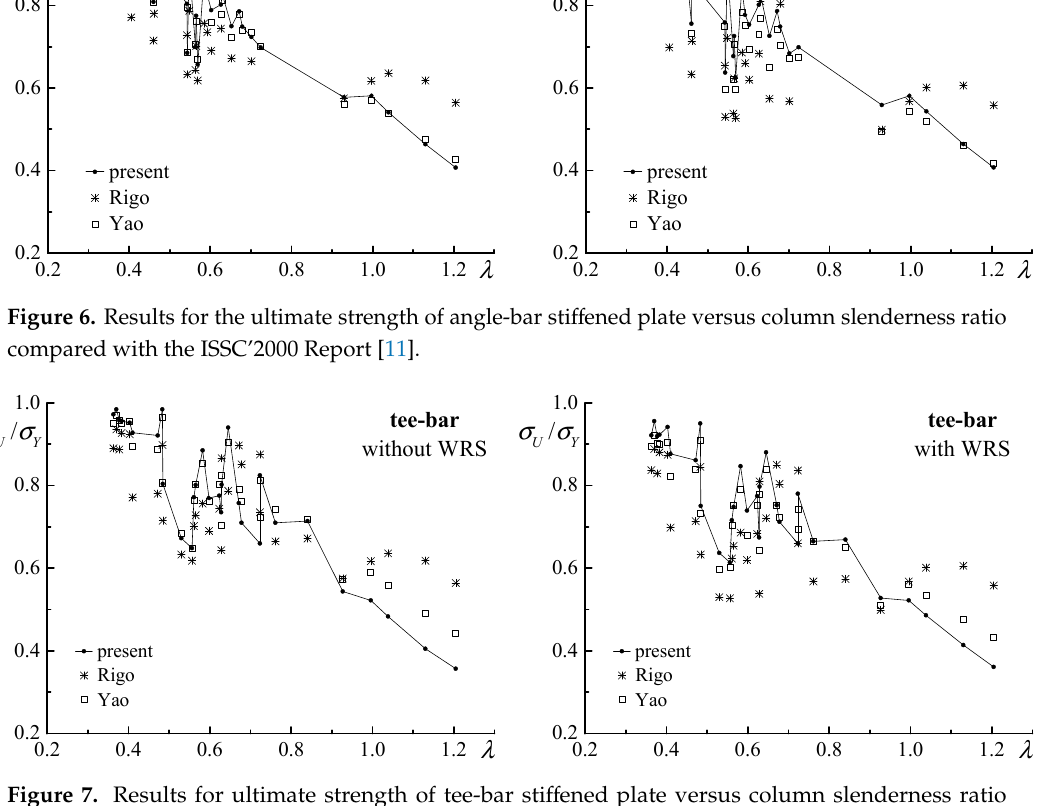
Figure 7. Results for ultimate strength of tee-bar stiffened plate versus column slenderness ratio compared with the ISSC’2000 Report [11].